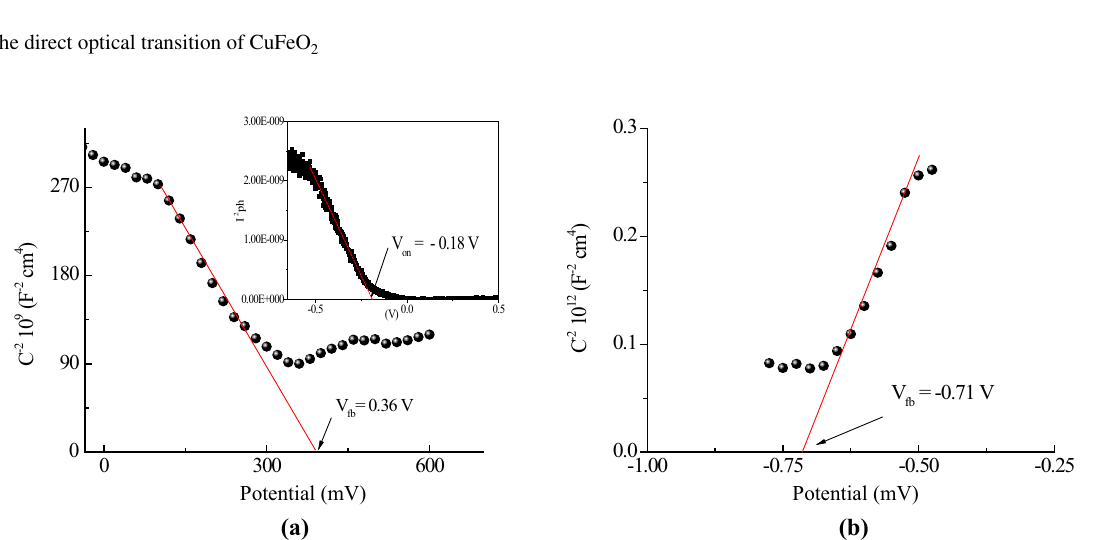
Fig. 3 a The Mott–Schottky plots in Na